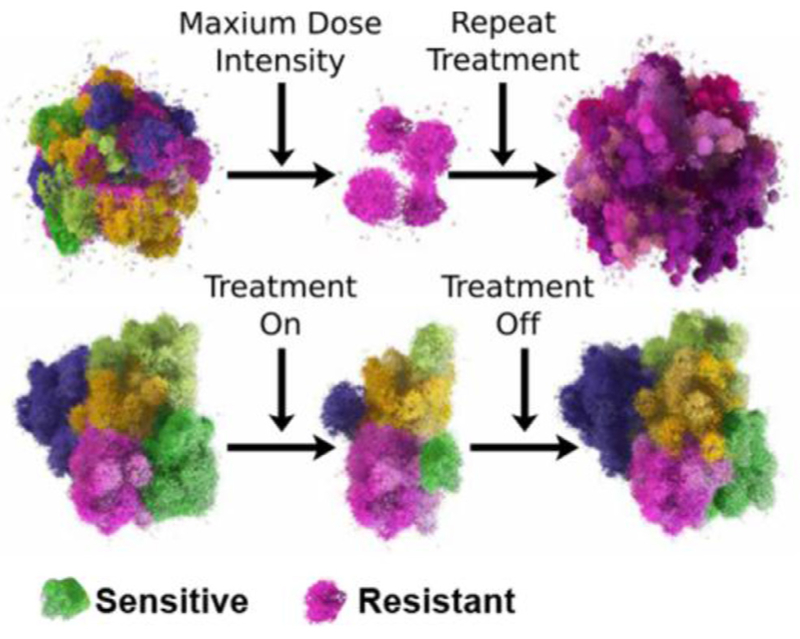
Conventional high dose therapy (top) maximally selects for resistant phenotypes (pink). Adaptive therapy (bottom) maintains a small population of cells that are sensitive to treatment. While the resistant cells survive, the cost of resistance renders them less fit in the absence of therapy. Thus, sensitive cells return when therapy is removed, suppressing growth of the resistant population.